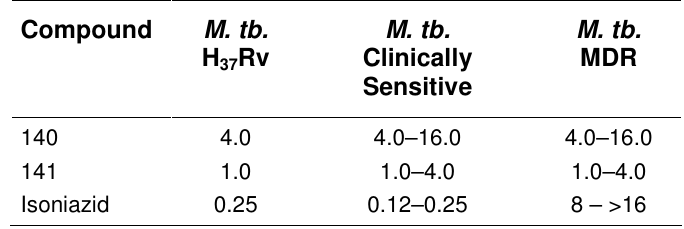
MIC Values ( µ g/ml) of Compounds 140 and 141 and Isoniazid